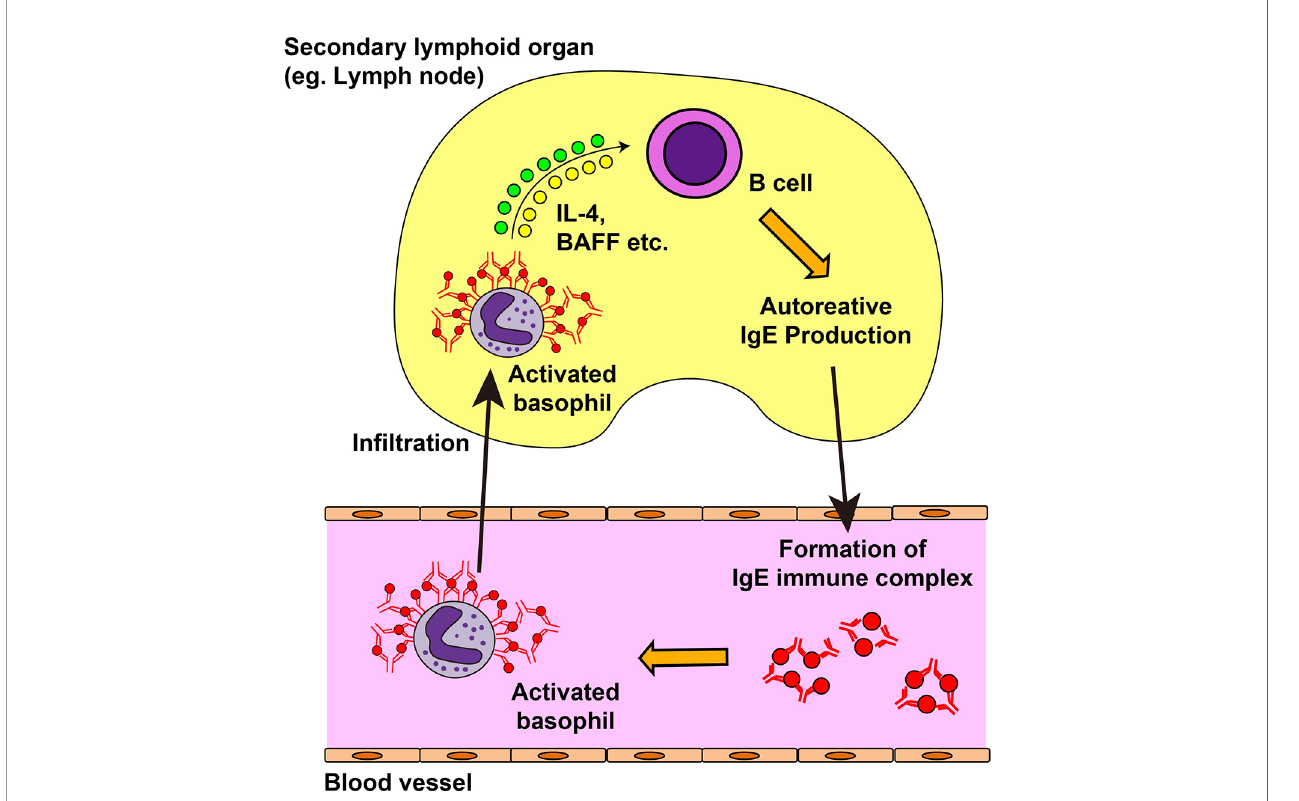
FIGURE 3 | Feedback loop for the exacerbation of systemic lupus erythematosus. In the mouse model of systemic lupus erythematosus (SLE) and in patients with SLE, autoreactive IgE antibodies can be detected in the blood. Autoreactive IgE antibodies form immune complexes with corresponding autoantigens and activate blood-circulating basophils. Activated basophils upregulate the surface expression of CD62L and CXCR4 and in fi ltrate into lymph nodes. They produce interleukin (IL)-4, IL-13, and B cell-activating factor (BAFF) which in turn induces autoantibody production from B cells, resulting in the deposit of immune complexes in the kidney and in disease